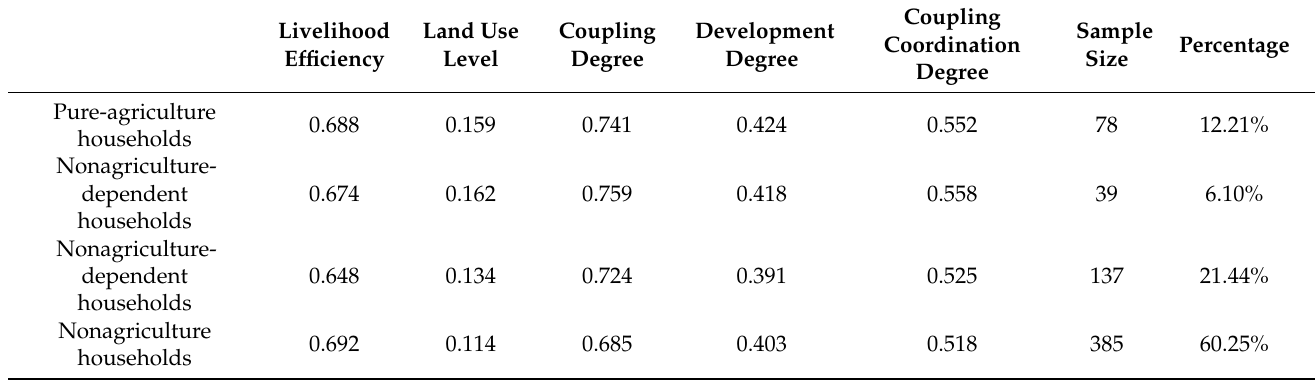
Table 6. Statistical results of the coupling coordination between different types of household livelihood efficiency and land use.